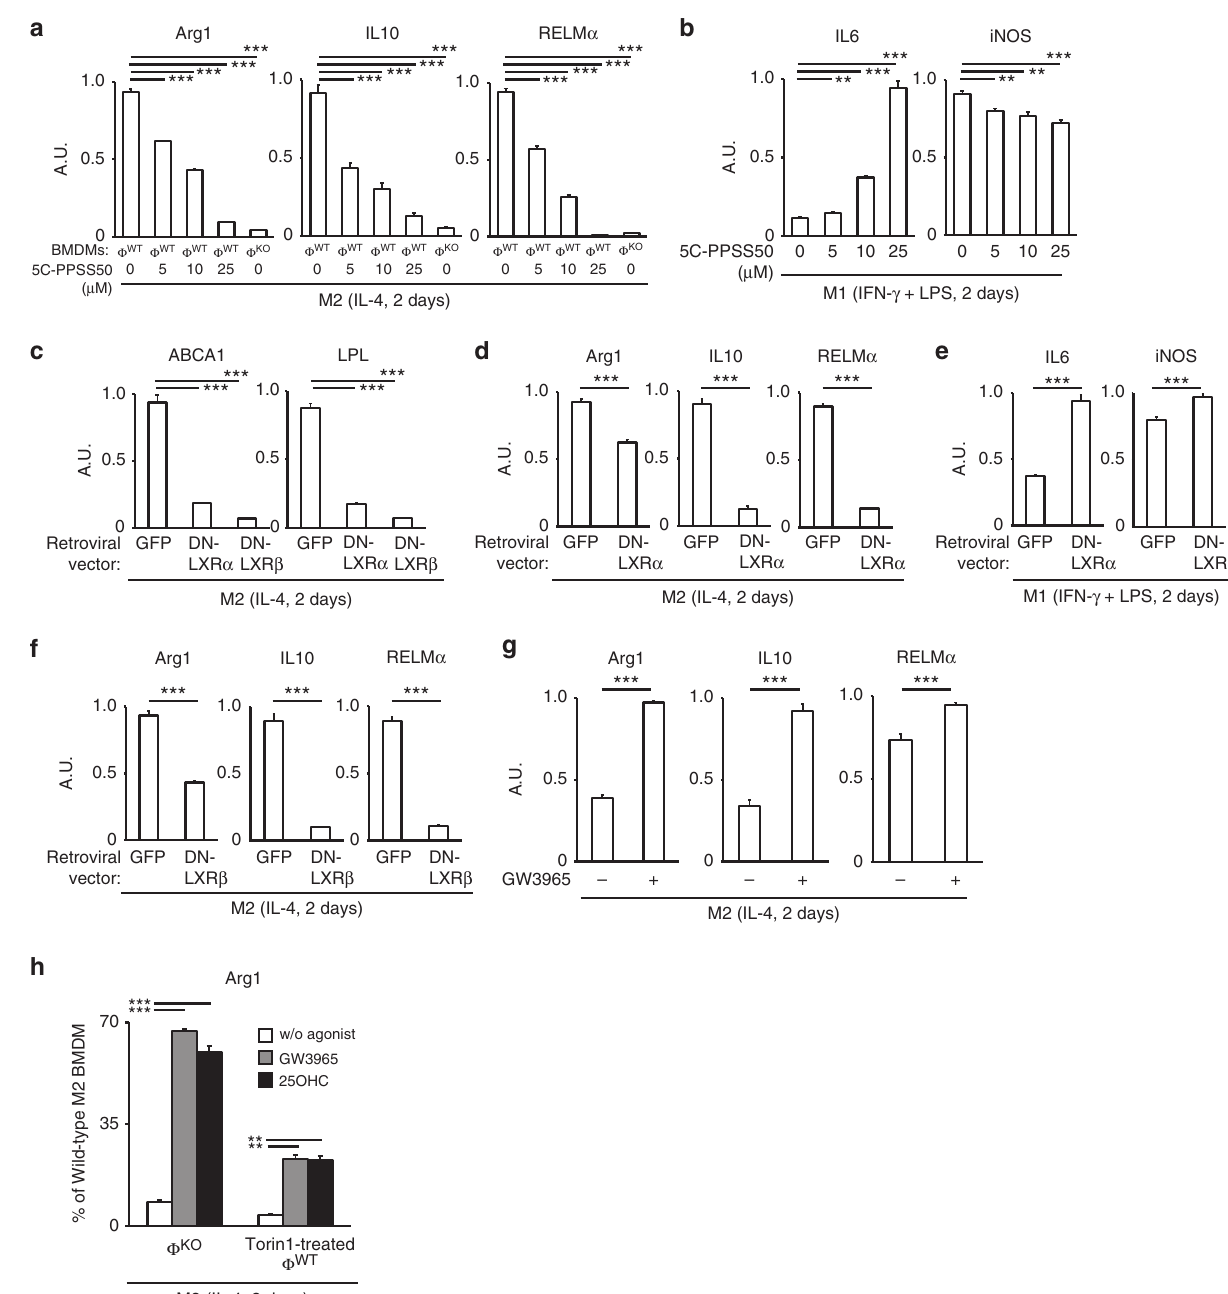
Figure 7 | Active LXR is required for M2 polarization. ( a , b ) Real-time PCR for M2 ( a ) and M1 ( b ) signature genes in BMDMs polarized with each stimulants and concomitantly used LXR antagonist. See Supplementary Fig. 8d for exclusion of unintended suppressive effect of the vehicle. ( c – f ) Overexpression of dominant-negative (DN) LXR a and LXR b in wild-type BMDMs and its effect on gene expression. ( c ) Real-time PCR for LXR-target genes confirmed the suppressive activity of DN-LXR a and DN-LXR b . ( d – f ) Real-time PCR for M2- ( d , f ) and M1- ( e ) marker genes. ( g ) Real-time PCR showed that concomitant stimulation with synthetic LXR agonist GW3965 and IL-4 increased expression of M2 marker genes in wild-type BMDMs, compared with IL-4 stimulation. ( h ) GW3965 or an LXR ligand 25-hydroxysterol rescued M2 polarization of both Lamtor1-deficient BMDMs and mTOR-inhibited wild-type BMDMs. F WT and F KO are defined as in Fig. 1. The representative results of three independent experiments are shown for